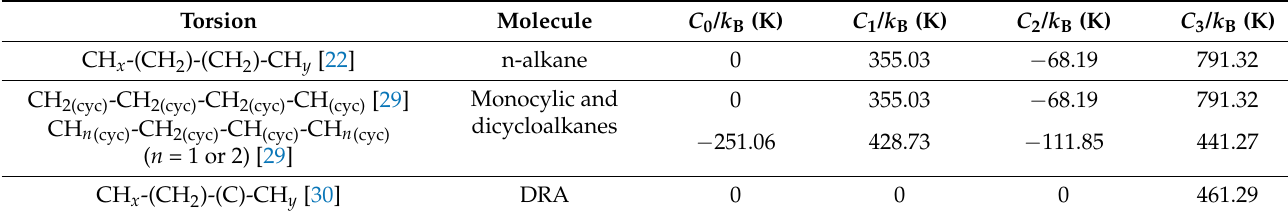
Table 5. Dihedral torsion parameters for the TraPPE-UA force